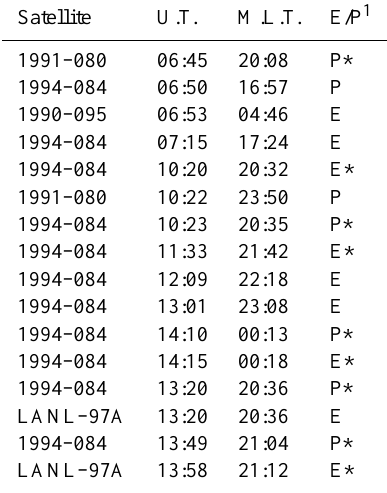
Table 1. LANL SOPA measurements of energetic particle flux de- creases, 30 November 2002. Satellite